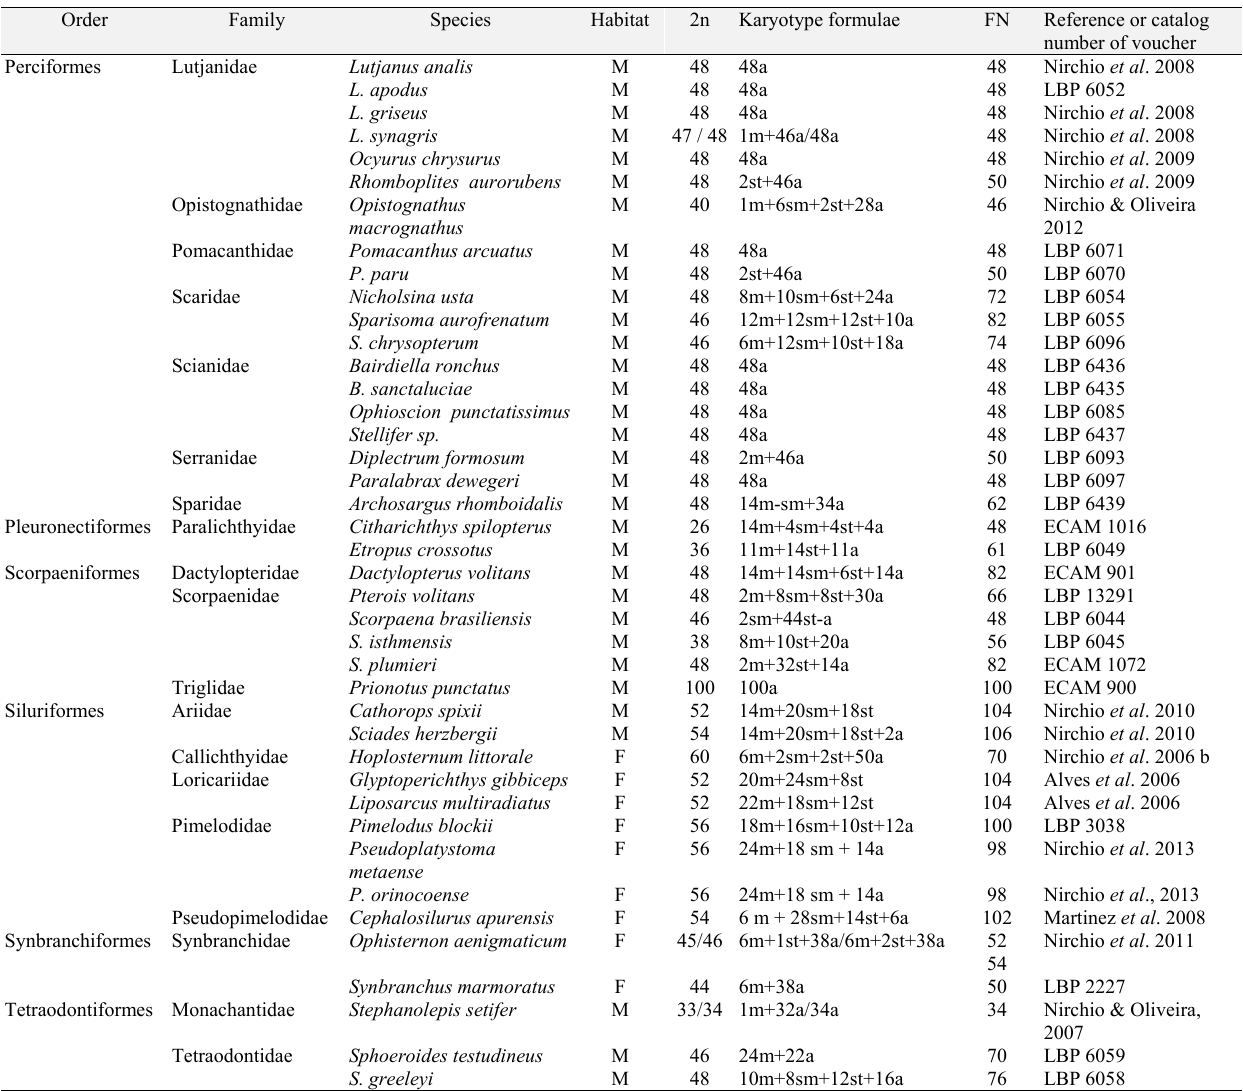
Table 2 (cont.). Karyotype characteristics for 103 species of fishes from Venezuela. M = marine, F = freshwater, m= meta-, sm = submeta-, st = subtelo- and a = acrocentric chromosomes. In the last column the catalog numbers of the voucher specimens of species whose results are firstly presented here. Classification follows Eschmeyer & Fong